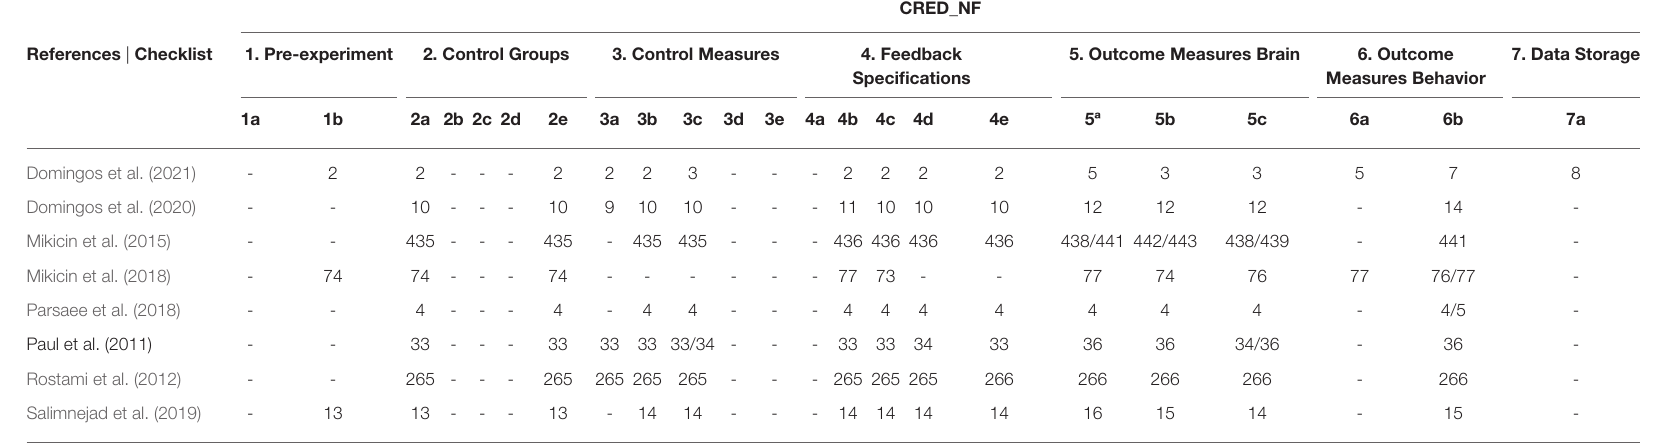
TABLE 1 | Consensus assessment on the reporting and experimental design of clinical and cognitive-behavioral neurofeedback studies